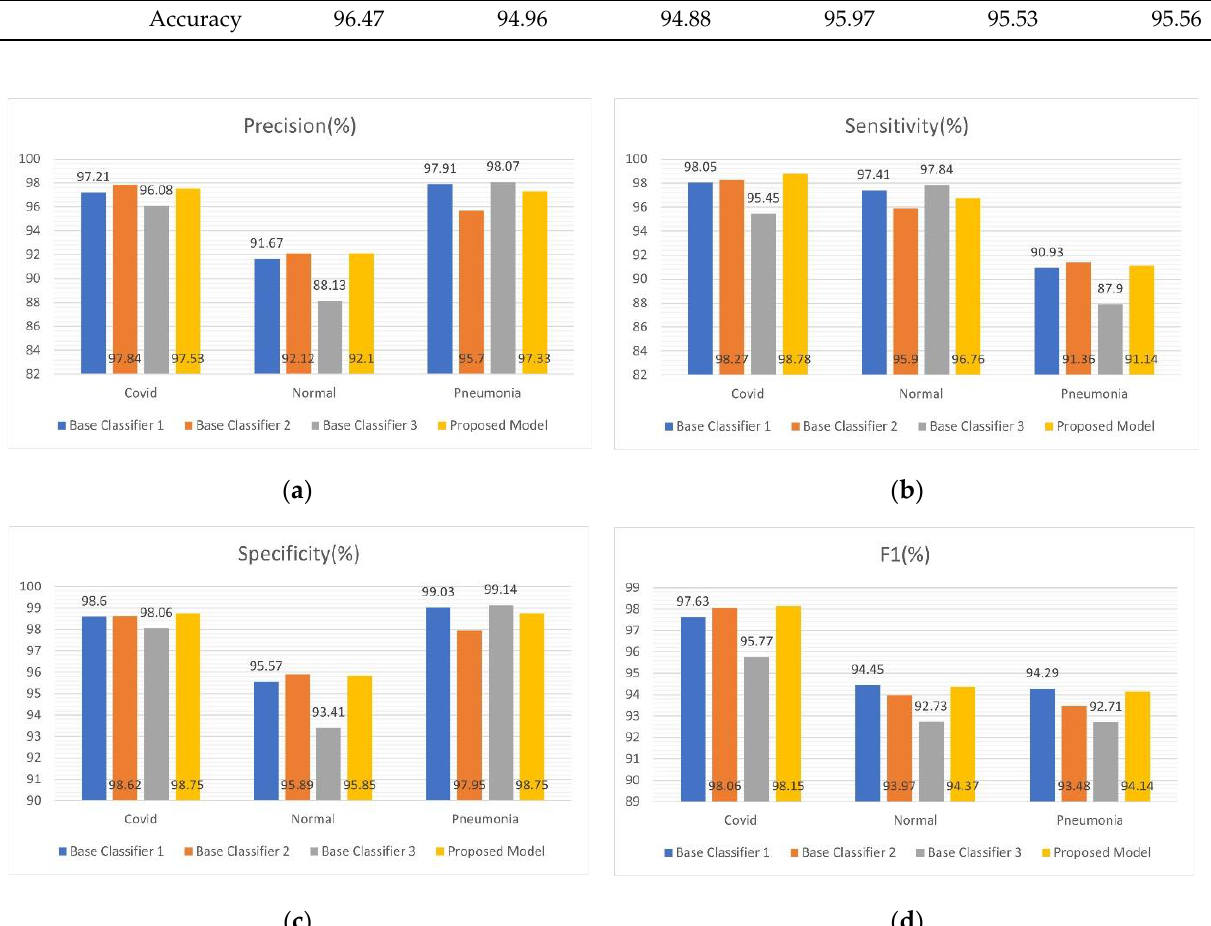
Figure 5. Three base classifiers are shown (base classifier 1 in the figure: Xception + coordinated attention module + LSTM layer + new classification head, base classifier 2: MobileNetV2 + coordinated attention module + LSTM layer + new classification head, base classifier 3: NasNetMobile + Coordinated attention module + LSTM layer + new classification head) and the proposed ensemble model COVIDX-LwNet (the model proposed in the figure) based on confidence fusion on the test